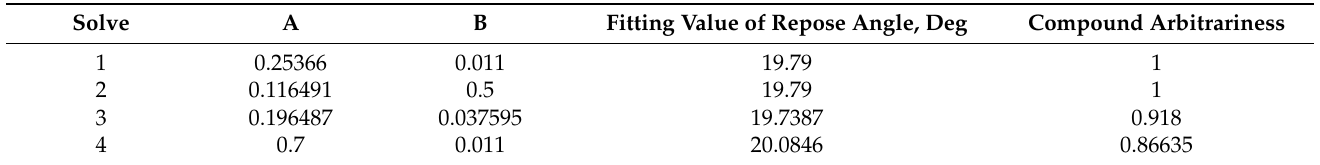
Table 6. Parameter optimization results of SN42.